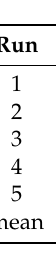
Table 8. OCV of the stack before each constant current run.